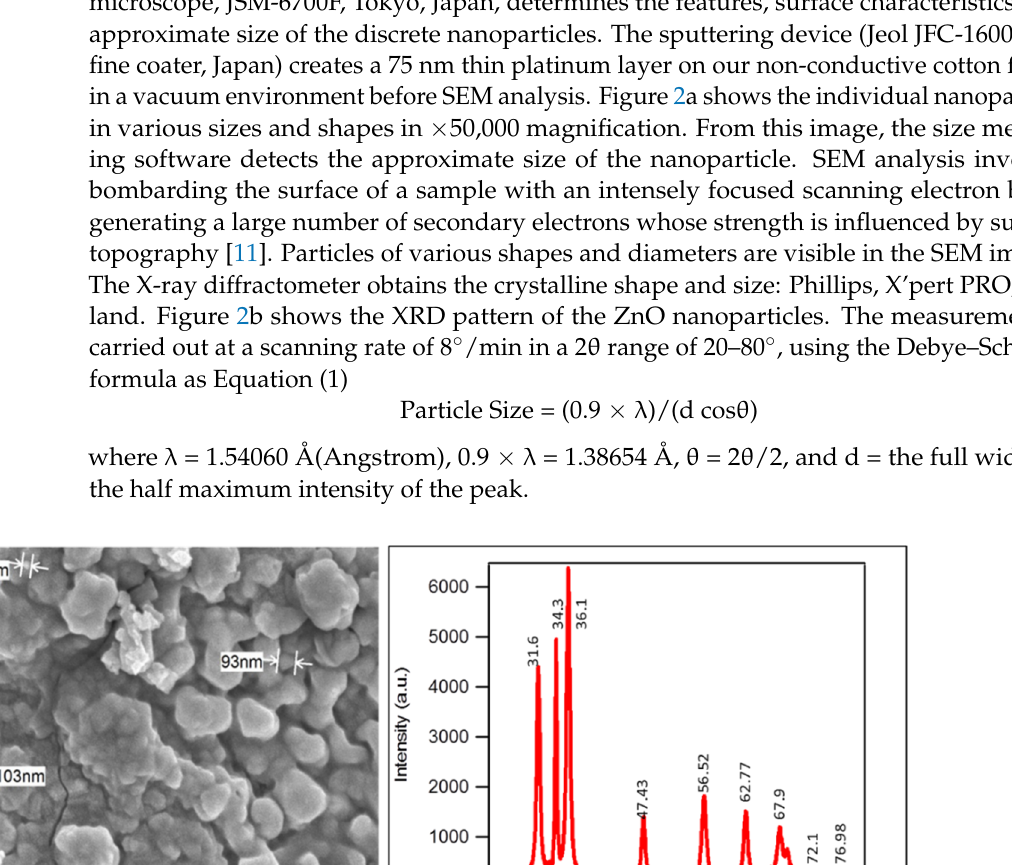
4 of 16 Figure 1. Experimental setup for the synthesis of ZnO nanoparticles. 2.3. Characterization of Nanoparticles The synthesized nanoparticles are characterized by high-resolution scanning electron microscopy (SEM) and X-ray diffraction (XRD) analysis. A field emission electron micro- scope, JSM-6700F, Tokyo, Japan, determines the features, surface characteristics, and ap-